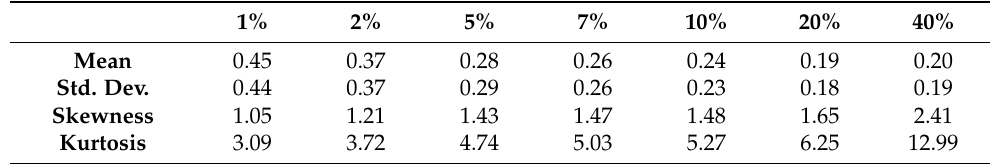
Table 9. Main statistics of the charge vector